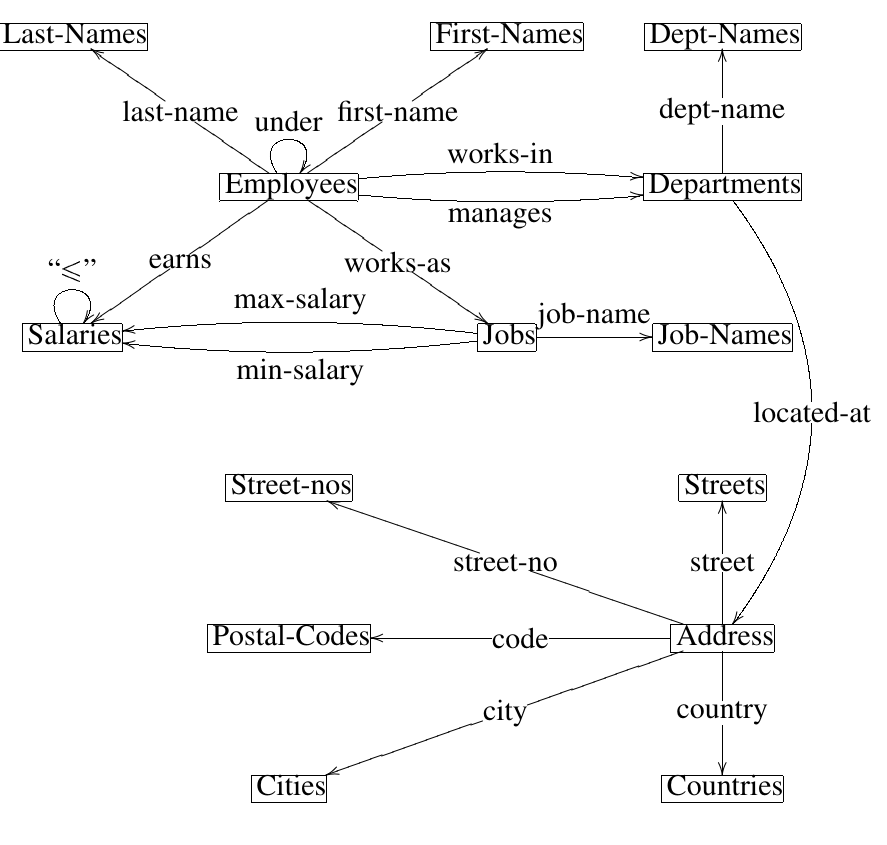
Figure 1. An example of an allegorical conceptual model graph.